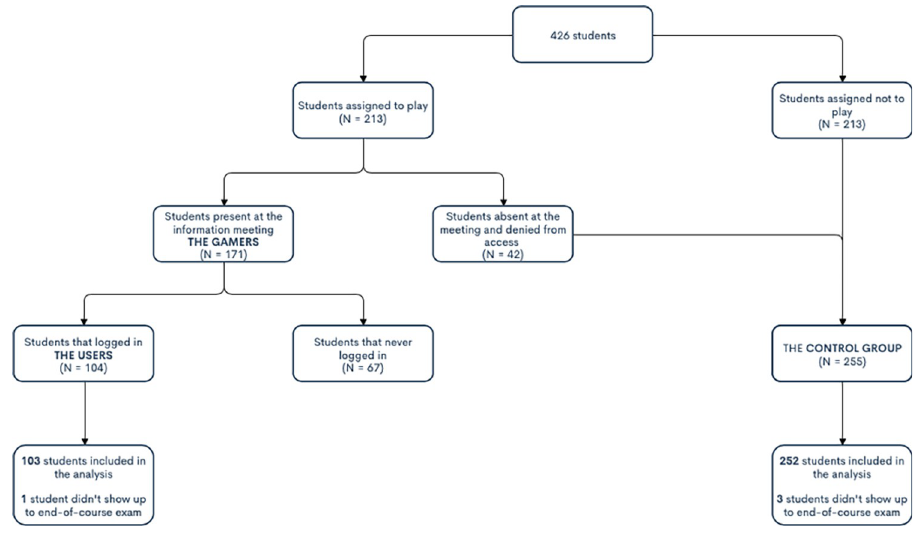
Fig 2. The Chatprogress trial’s flow chart.